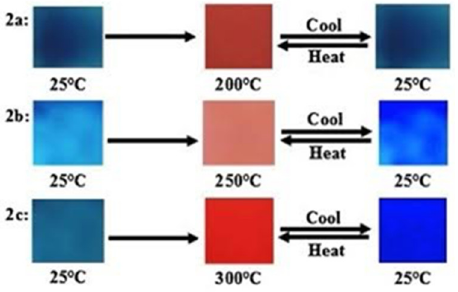
Figure 4. Photographs of the PDAs 2a–2c recorded upon increasing temperature from 25 °C to 300 °C and then cooling to room temperature. Reproduced with the permission of Reference [16] Copyright 2017 Elsevier.